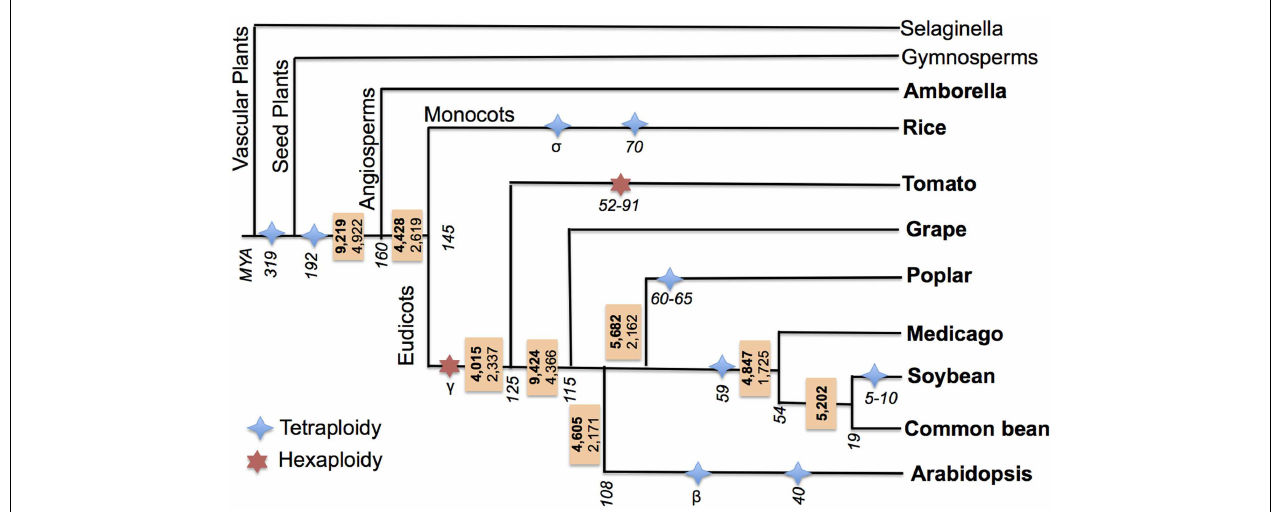
length. Divergence of clades andWGD event timings are in MYA and are italicized, these are based on the following (Tuskan et al., 2006; Fawcett et al., 2009; McClean et al., 2010; Jiao et al., 2011;Woodhouse et al., 2011;Young et al., 2011; Paterson et al., 2012; Roulin et al., 2012; Amborella Genome Project,